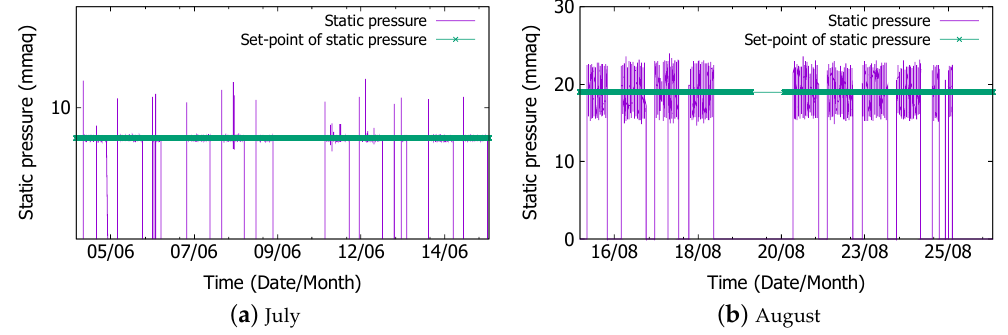
Figure 6. Comparison of static